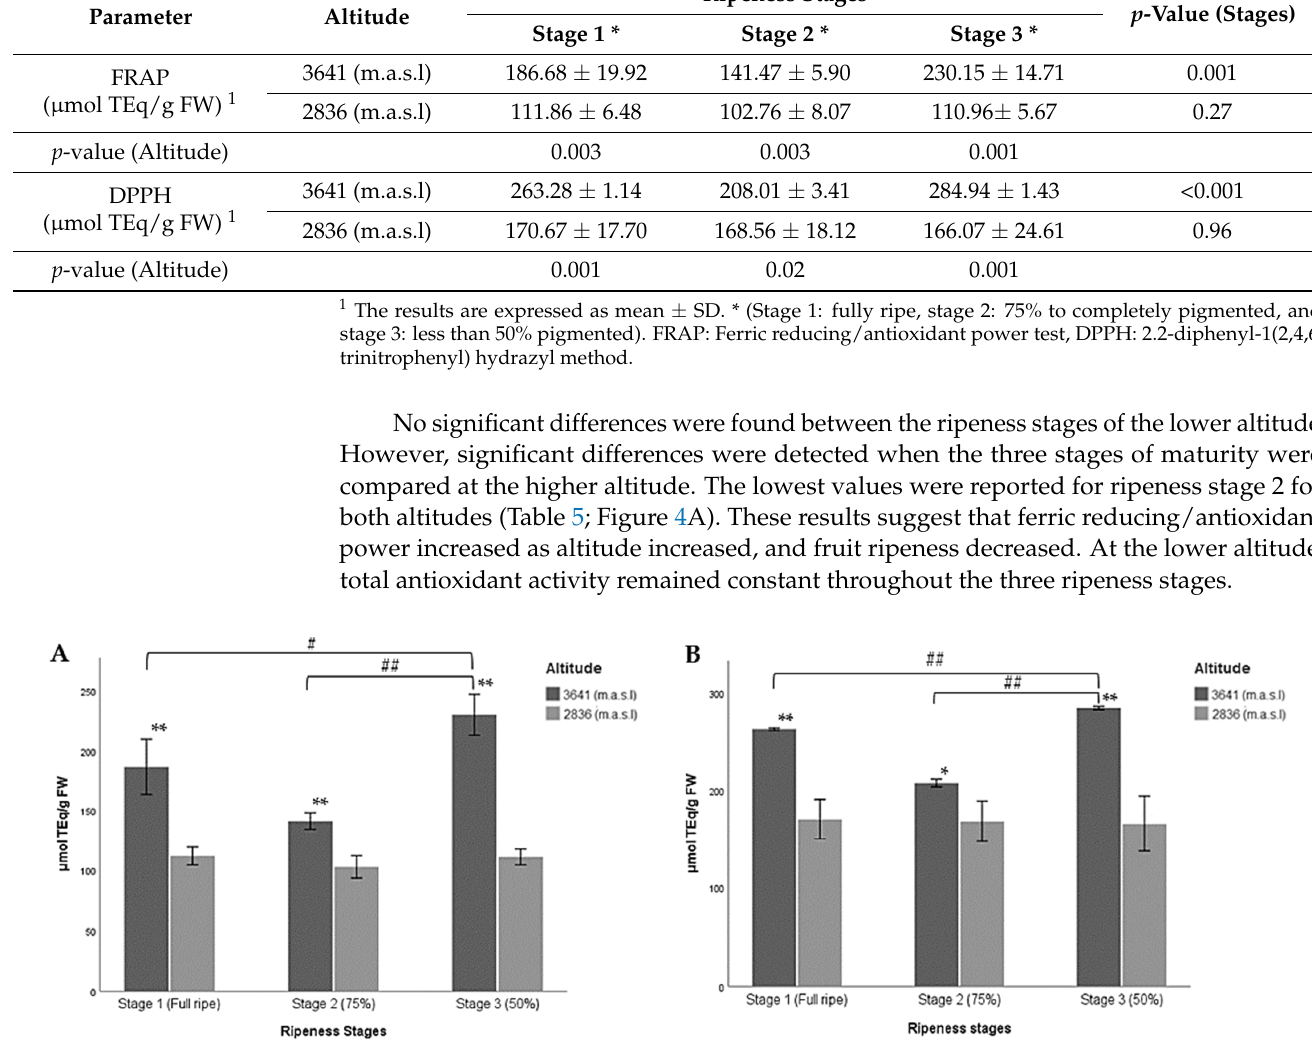
Table 5. Antioxidant capacity of Andean blueberries ( V. floribundum Kunth) as affected by site altitude and ripeness.